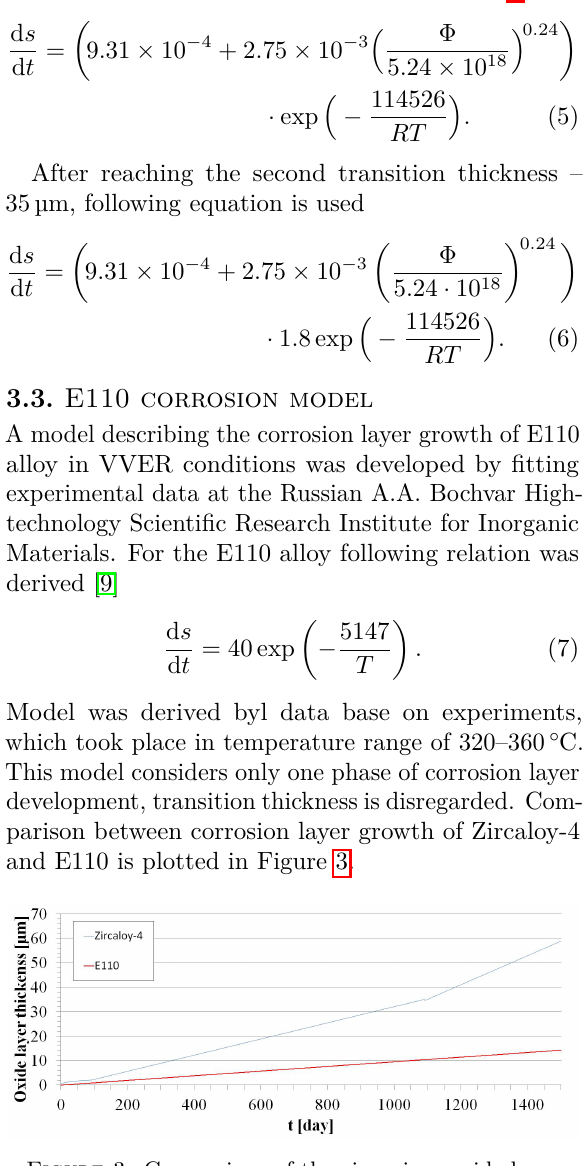
Figure 3. Comparison of the zirconium oxide layer thickness of Zircaloy-4 and E110 alloys in conditions of 320 ◦ C and neutron flux of 1E15 neutrons/ m 2